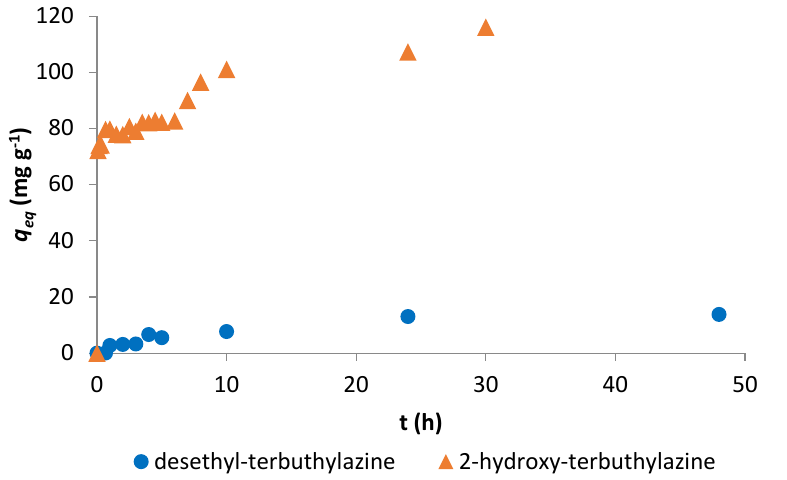
Figure 3. Sorption kinetics for desethyl-terbuthylazine and 2-hydroxy-terbuthylazine on modified poly(divinylbenzene) microspheres.